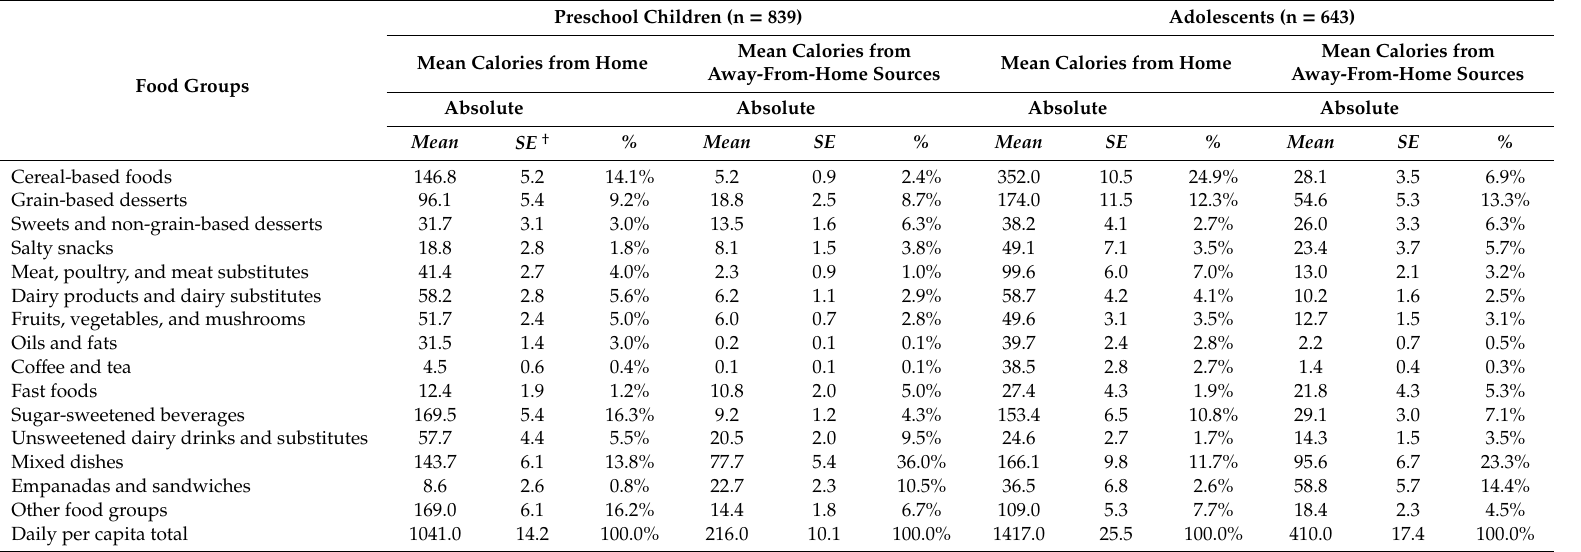
Table 4. Percentage of per capita total daily calories from food groups by food source (home, away from home) * among low- and middle-income Chilean preschool children and adolescents from Southeast Santiago,